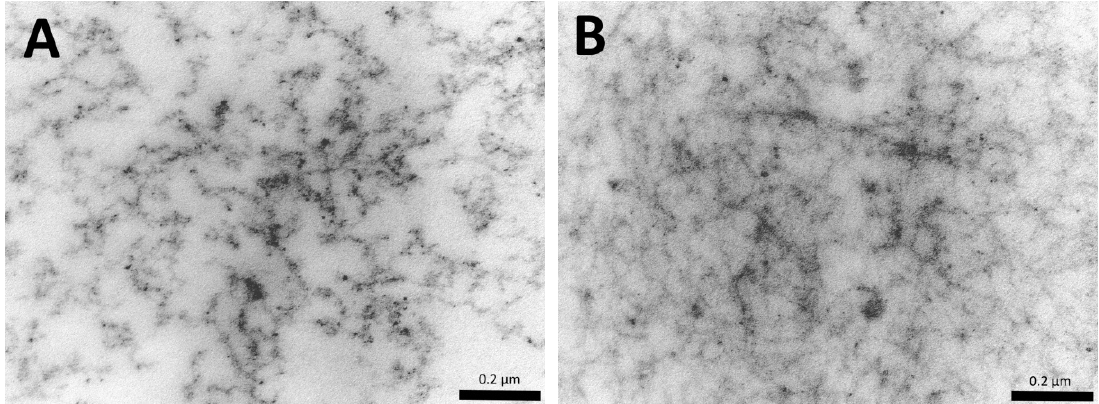
Figure 4. Change in the structure of scaffolds: ( A )—first day of cultivation, ( B )—10th day of cultivation (transmission electron microscopy).